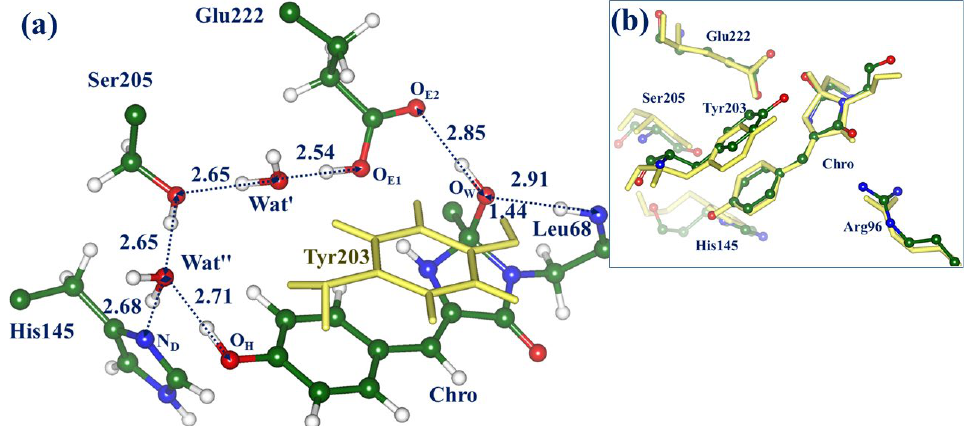
Figure 5. The active site in the QM/MM computationally derived OFF-state (panel ( a )). Panel ( b ) shows superposition of fragments of the active site in the QM/MM-optimized structure (colored balls and sticks) and in the crystal structure PDB ID 3ST3 [1] (yellow stick). The interatomic distances are given in Å.